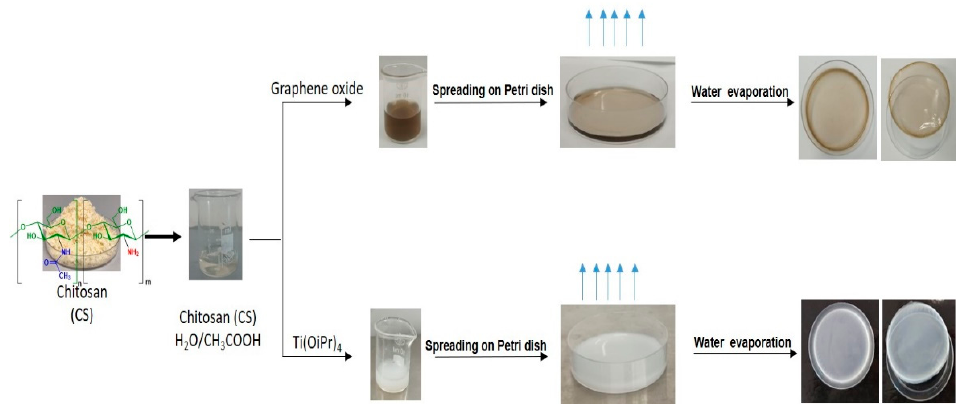
Figure 9. Preparation scheme of chitosan-clustered metal oxide films and chitosan graphene nanocomposite films.